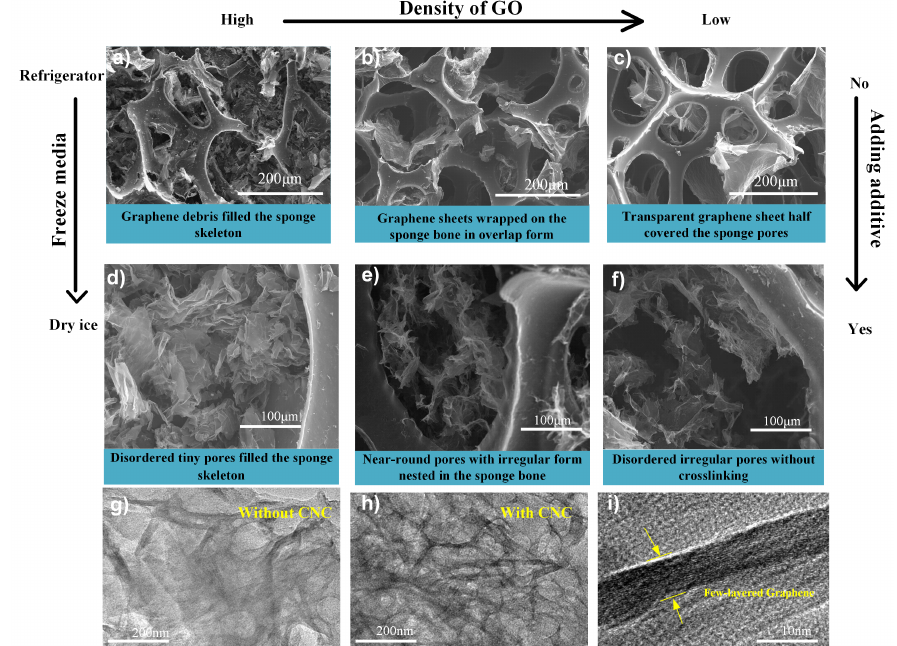
Figure 3. Microscopic structures of spongy CNC-graphene aerogels. ( a – f ) CNG prepared with different GO concentrations and freezing media exhibit distinguished structures; ( a ) 5 mg/mL,